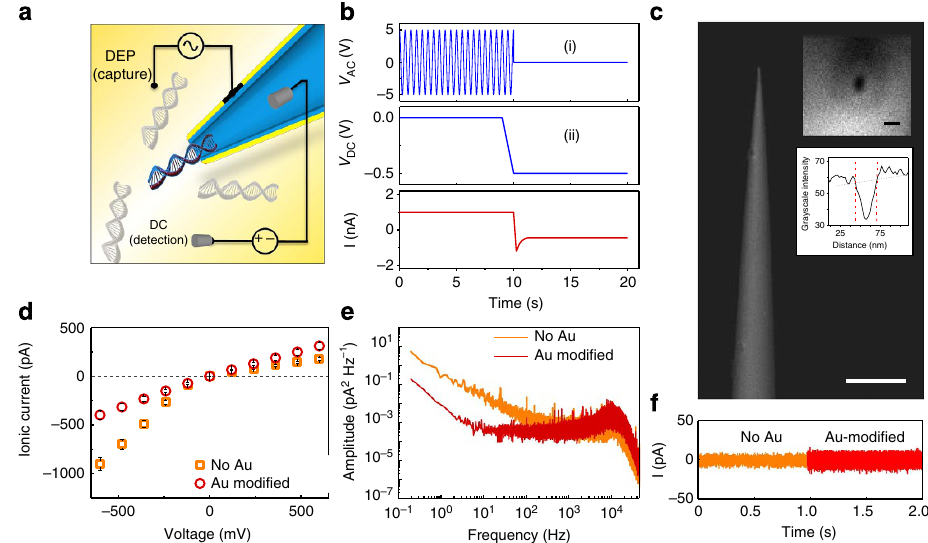
Figure 1 | Experimental setup and characterization of gold-coated nanopipettes. ( a ) Schematic of DNA being threaded through the tip of a gold-coated nanopipette. ( b ) Schematic of the voltage protocol used for DEP pre-concentration phase via AC voltage (i) and subsequent nanopore translocations via DC voltage (ii). All three channels ( V AC , V DC , I ) are simultaneously recorded. ( c ) SEM of a gold-coated nanopipette; scale bar, 5 m m (insets: SEM and intensity line plot of the tip visualized parallel to the barrel; scale bar, 50nm). ( d ) Current–voltage curves for glass nanopipettes before and after gold coating. Gold coating thickness was B 5nm. ( e ) Power spectral density of pipettes under a negative 500mV voltage bias. ( f ) Baseline-subtracted time traces of the pipettes before and after gold coating at a negative 500mV voltage bias and 1mM